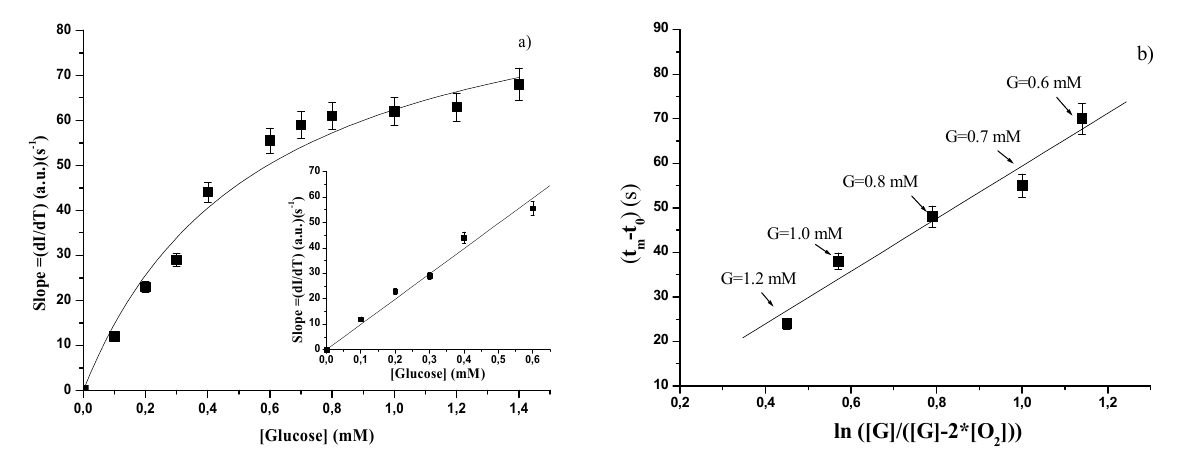
Figure 5. Free GOD – (a) Slope of the intensity rise of fluorescence signal as a function of glucose concentration. Inset: glucose calibration curve. b) (t function of ln([G]/([G]-2([O